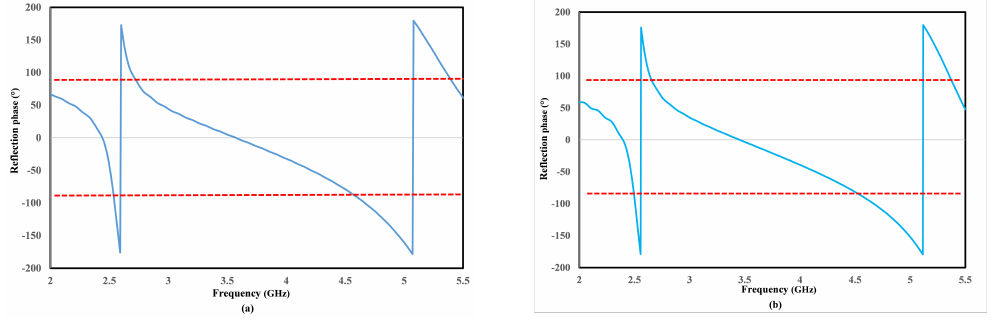
Figure 3. In-phase reflection of EBG unit cells. ( a ) Mushroom-like unit cell. ( b ) Unit cell with plus-shaped slots.